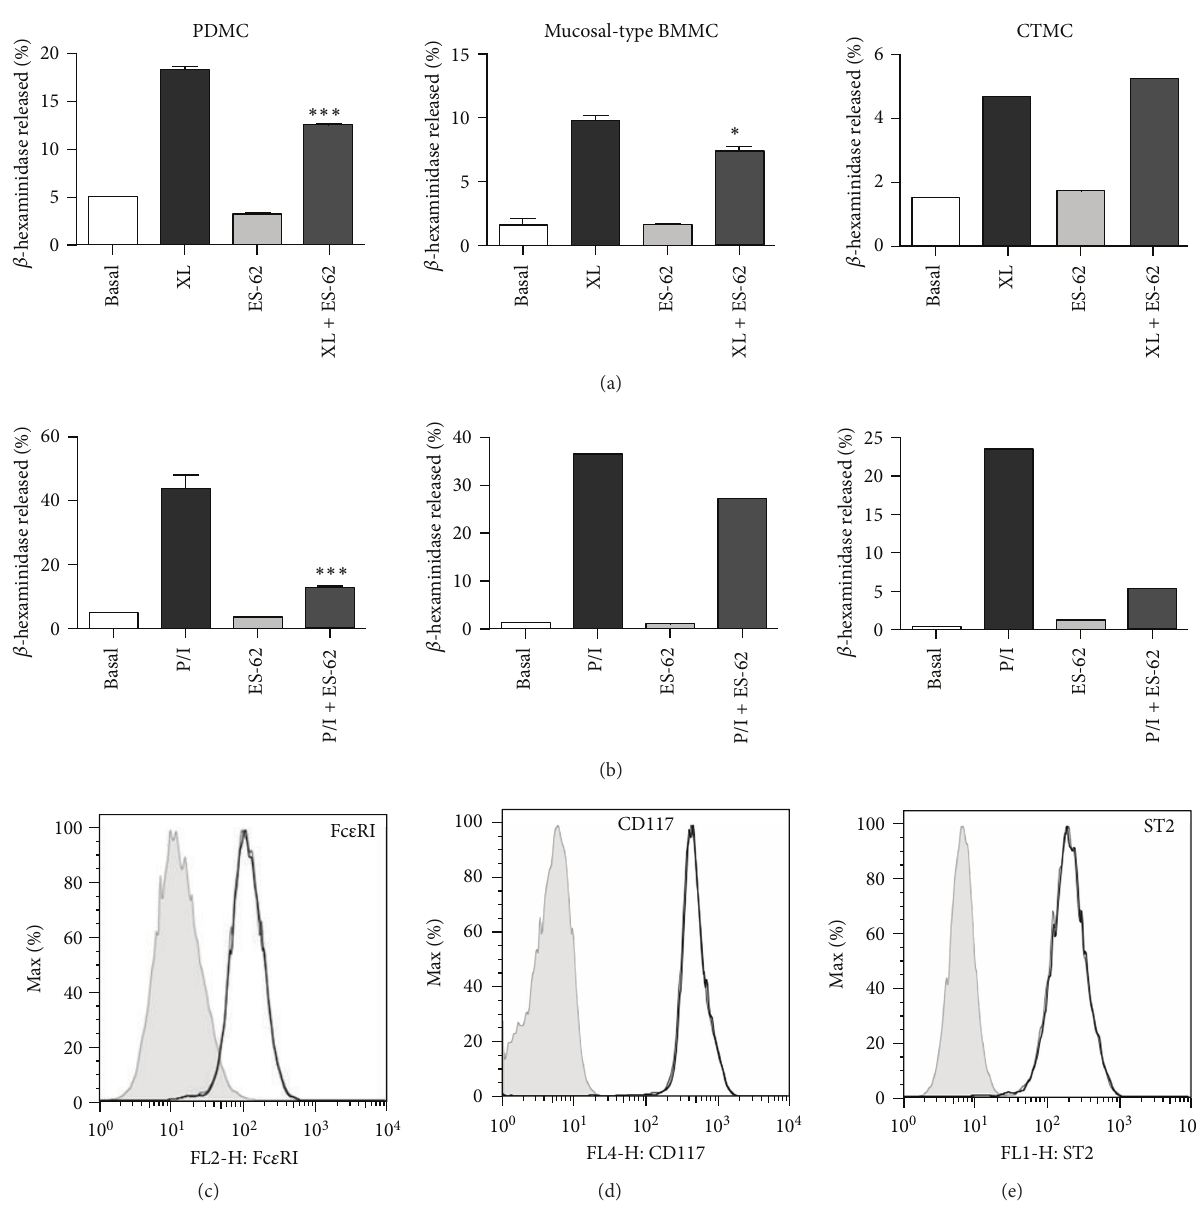
Figure 2: Degranulation by mast cell subsets. Mucosal-type BMMC, CTMC and PDMC were sensitised with murine anti-DNP IgE (0.5 𝜇 g/mL) in the presence and absence of ES-62 (2 𝜇 g/mL) overnight. Cells were then stimulated with DNP (0.5 𝜇 g/mL) to induce Fc 𝜀 RI cross-linking(XL;(a))orPMAplusionomycin(both1 𝜇 M;(b))for30minat37 ∘ C.Degranulationwasdeterminedasthe% 𝛽 -hexosaminidase release relative to the total enzyme activity of the cells and the data presented are from single experiments representative of at least 2 independent experiments. PDMC were sensitised with murine anti-DNP IgE (0.5 𝜇 g/mL) in the presence and absence of ES-62 (2 𝜇 g/mL) overnight and analysed for expression of Fc 𝜀 RI (c), CD117 (d), and ST2 (e). Grey shaded plots (c–e) are relevant isotype controls.